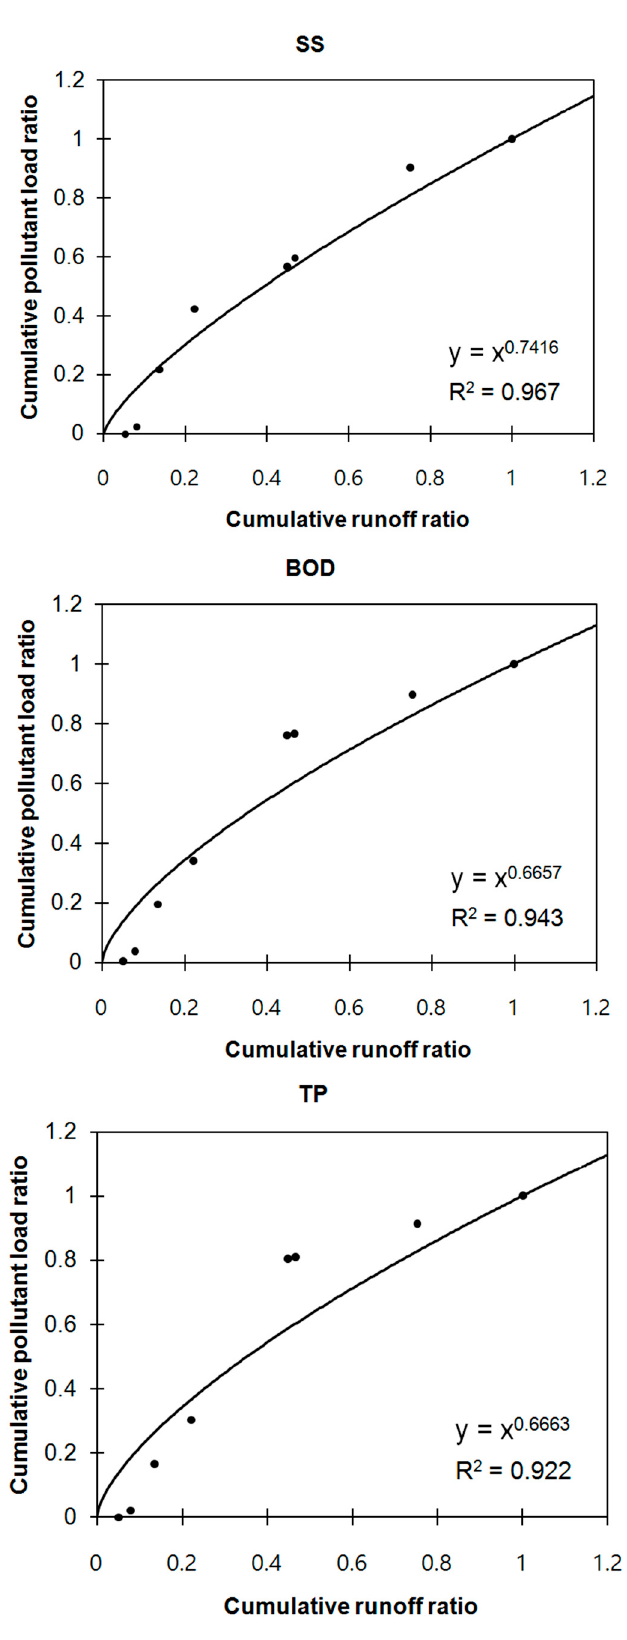
Figure 8. M(V) curve fitting using the power function for Naedongcheon (2–3 October 2016). Figure 8. M ( V ) curve fitting using the power function for Naedongcheon (2–3 October